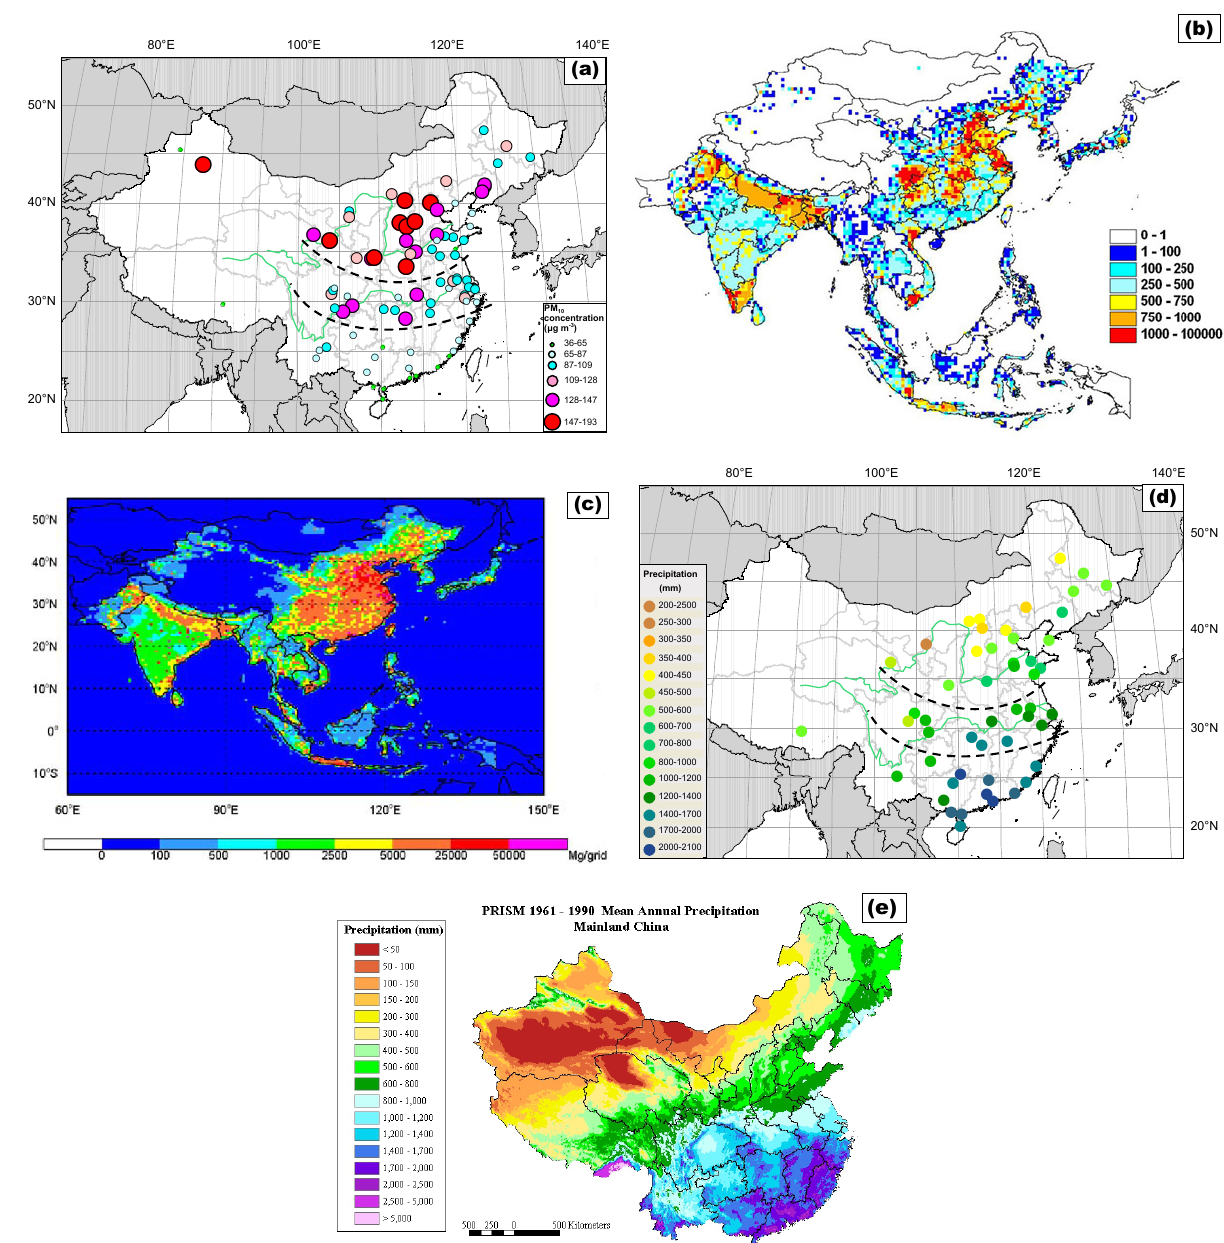
Fig. 5. (a) Spatial distribution of the multi-year (2000 – 2006) average PM 10 concentrations for the eighty-six Chinese cities; (b) Total